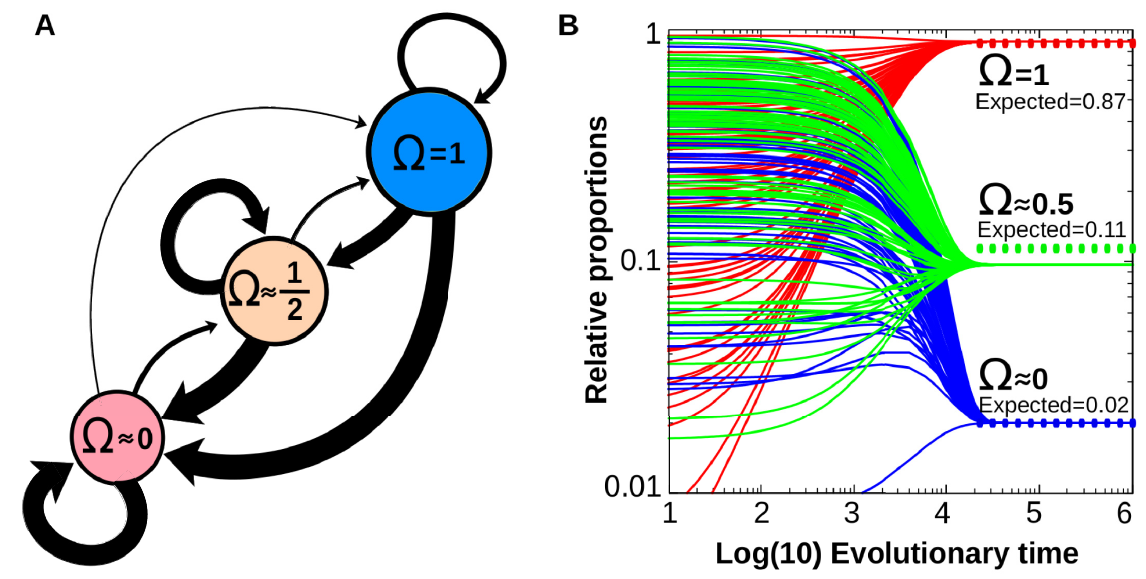
Fig 5. Evolvability assays. A. Transitions from complex forms of cell plasticity to simpler ones are evolutionary favoured. The width of each arrow is inversely proportional to the number of generations required for the transition from a specific multi dimensional reaction norm to another one (the wider the arrow the more probable the evolutionary change). The area of each circle is proportional to the average evolvability of each multi dimensional reaction norm. B. Predicting the relative frequency of each type of cell plasticity from transition probabilities. Numerical simulations for the expected long-term distribution of each type of plasticity derived from the probability transitions shown in A (see Eq (7). Convergence, steady state values (0.8833, 0.0966 and 0.0201) are similar to those expected (dashed lines) according to the random scanning of the GRN space (Experiment 2), suggesting that the differential evolvability (the different probability transitions between different forms of cell plasticity) emerges from the drastic differences in the relative frequency of each type of cell plasticity in the GRN space.